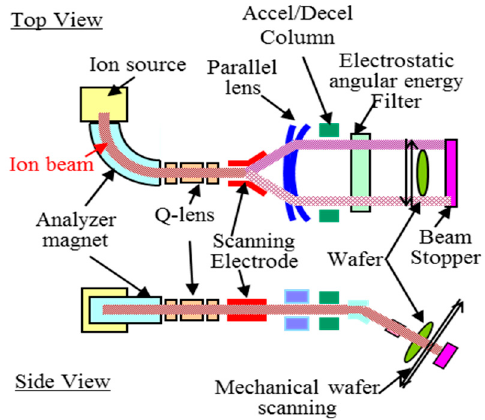
Figure 2. The top view and side view block diagrams of a medium current ion implanter, NV-MC3-II, of SMIT [14].